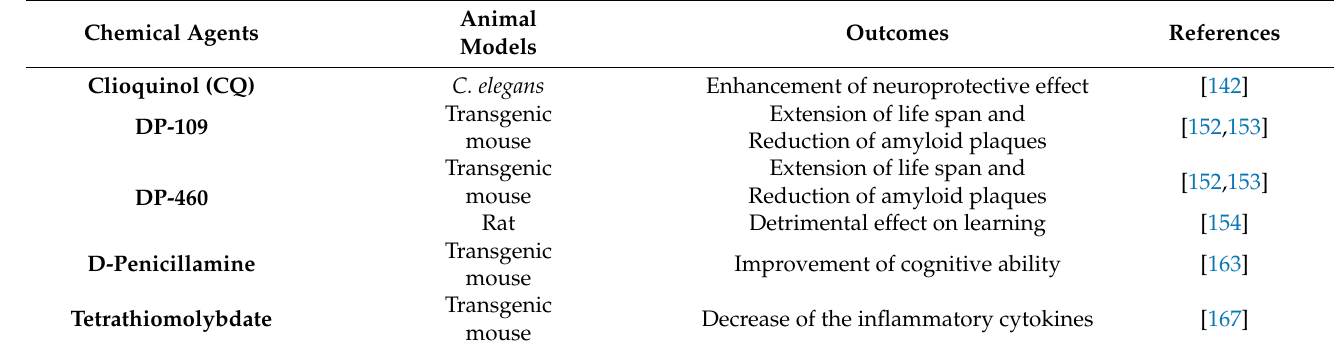
Table 2. Recent animal studies conducted with Cu-targeting chemical agents. Results of in vivo experiments performed with clioquinol ( CQ ), DP-109 , DP-460 , D-penicillamine , and tetrathiomolybdate are